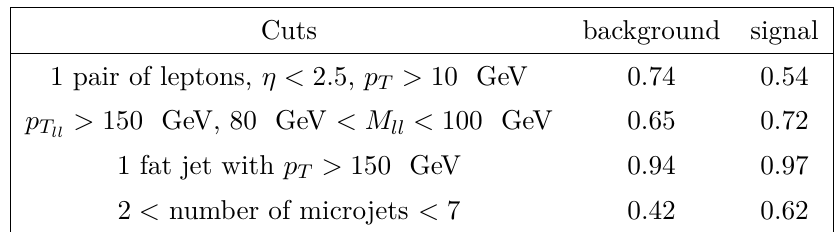
Table 1. Cut efficiencies relative to the previous event reconstruction step for signal and back- ground